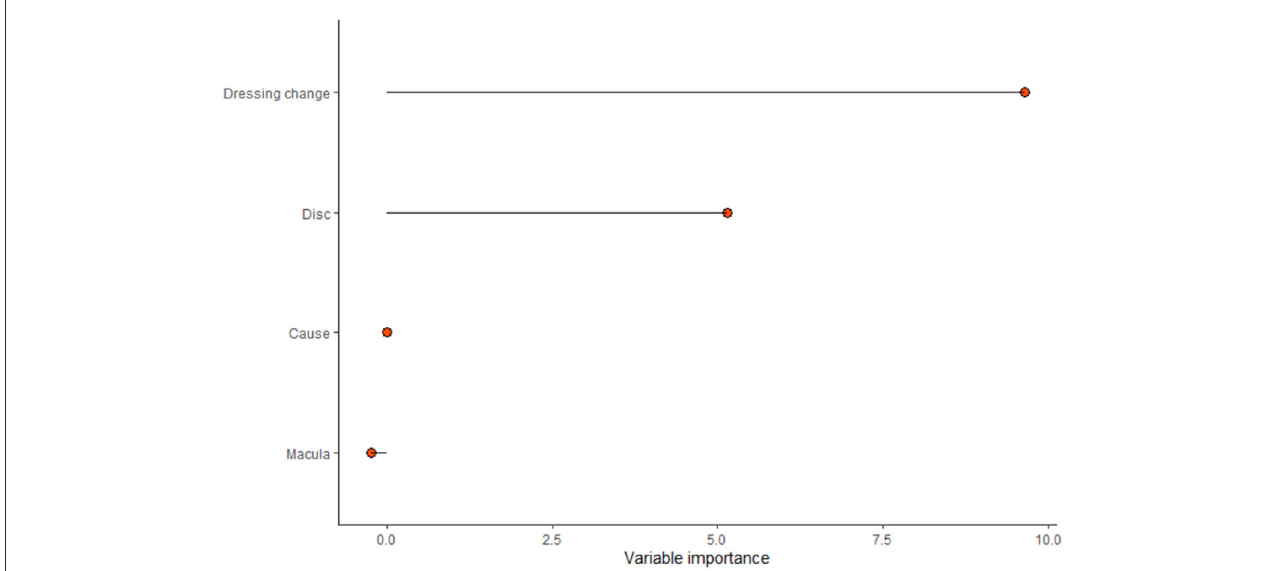
FIGURE6 The importance of factors affecting prognosis: The most important was the times of dressing change, followed by the central microvessel density of the optic disc, the cause of injury, and the microvessel density above the macula.